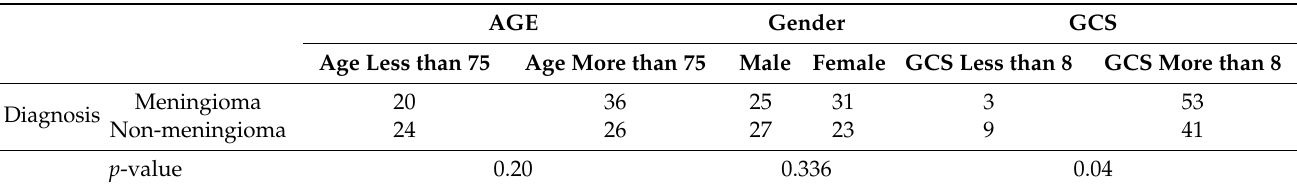
Table 3. The association between the LOS of the patients and other variables (age and type of intervention). Figure 1 represents the average age of the patients among the different types of tu- mors’, in which the GBM patients were found to have the highest mean age (72.6 years) followed by other tumors (hemangioma, lymphoma, schwannoma) tumors and pituitary tumors’ respectively (72.1 years, 71.4 years). It also demonstrates that patients with meta- by GBM patients (mean of 19.2 days).